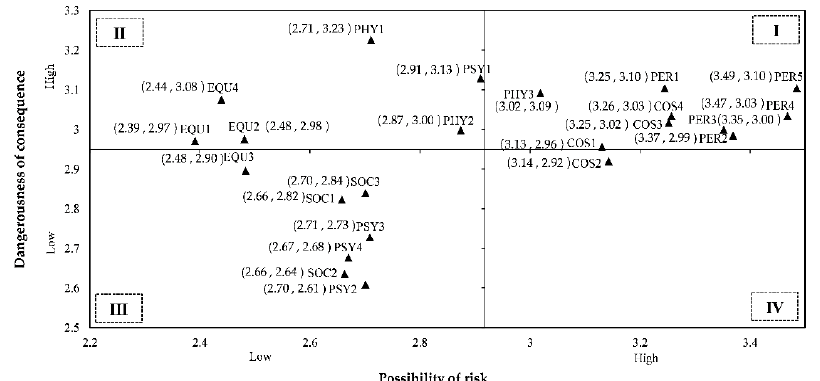
Figure 5. Quadrant distribution of perceived risk possibility and dangerousness of consequence. Note 1. PHY = Physical risk, EQU = Equipment risk, COS = Cost risk, PSY = Psychological risk, SOC = Social risk, PER = Performance risk. Note 2. The average values were in parentheses.